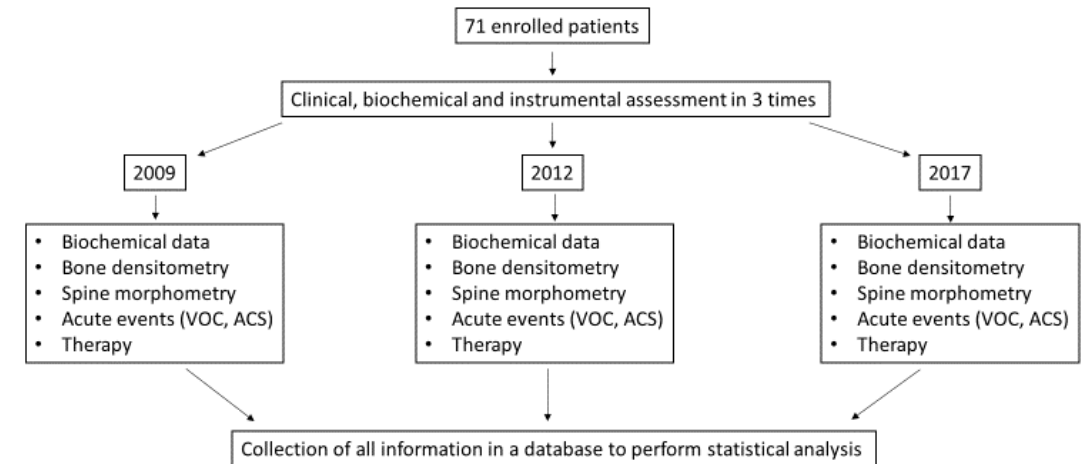
Figure 1. Flow-chart of the study. VOC: vaso-occlusive crisis; ACS: acute chest